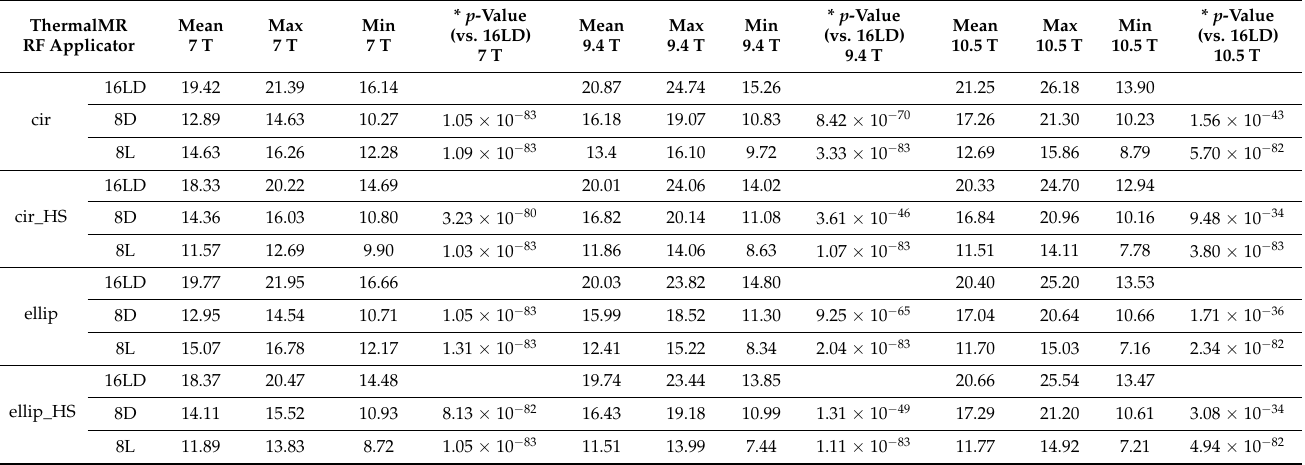
Table 2. Summary of statistical analysis of B 1+ transmission field for MRI performance of the ThermalMR RF